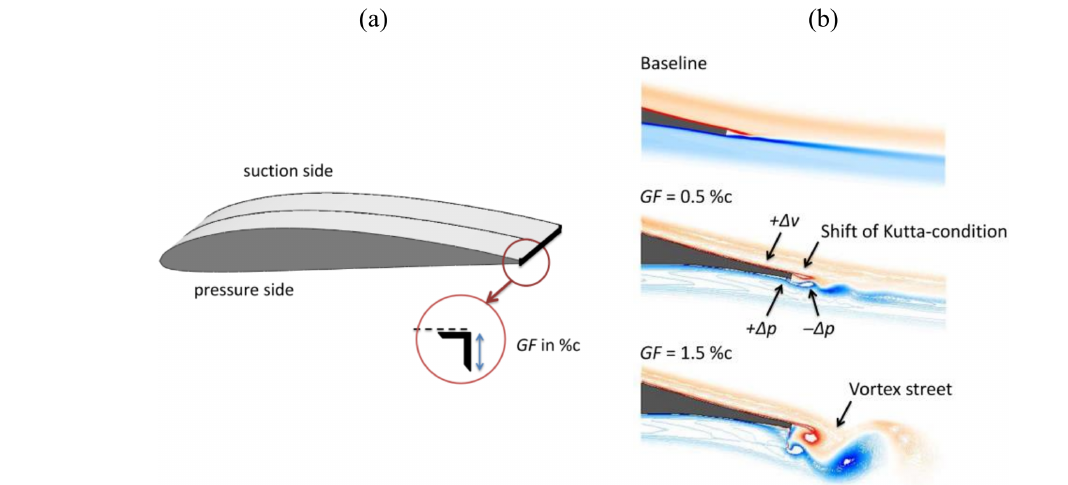
Figure 2. (a) Position of the Gurney flap at the trailing edge of a Clark-Y airfoil section. (b) CFD simulation of the HQ17 airfoil at Re = 1 . 0 × 10 6 , reproduced and modified from Schatz et al.